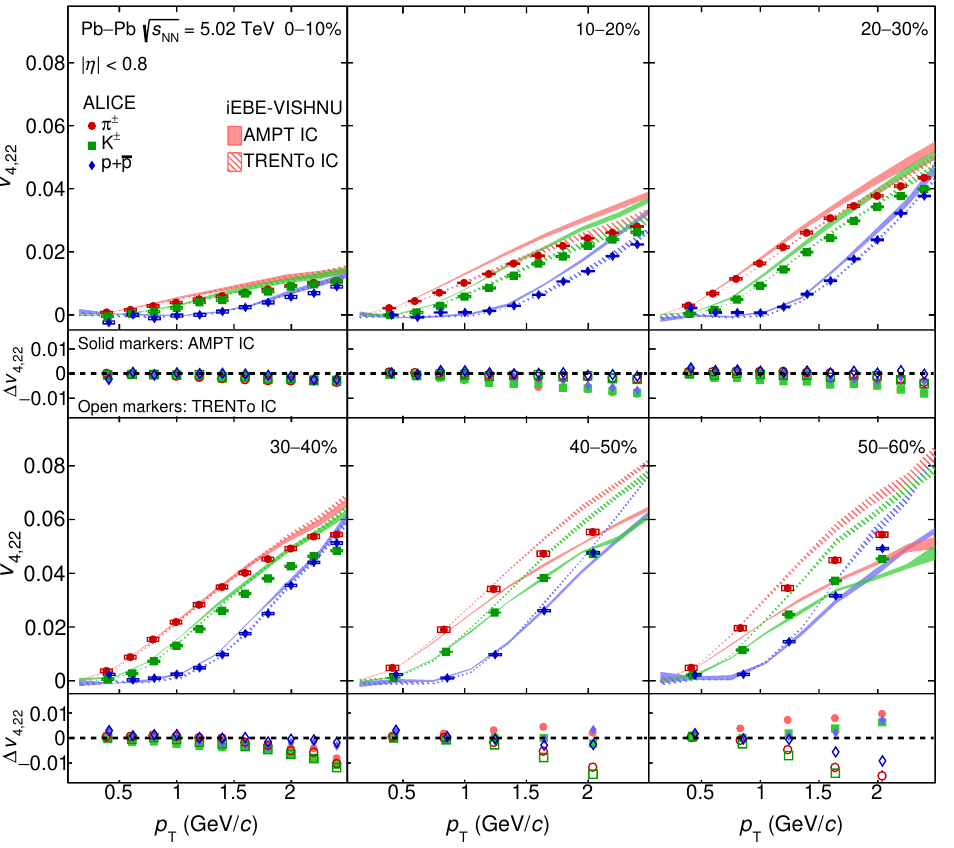
Figure 15 . The p T -di(cid:11)erential v 4 ; 22 of (cid:25) (cid:6) , K (cid:6) and p + p in the 0{10% up to 50{60% centrality p intervals of Pb-Pb collisions at s NN = 5 : 02 TeVcompared with iEBE-VISHNU hybrid models with two di(cid:11)erent sets of initial parameters: AMPT initial conditions ( (cid:17)=s = 0.08 and (cid:16)=s = 0) shown as solid bands and TRENTo initial conditions ( (cid:17)=s (T) and (cid:16)=s (T)) as hatched bands. The bottom panels show the di(cid:11)erence between the measurements and each model. Statistical and systematic uncertainties are shown as bars and boxes,